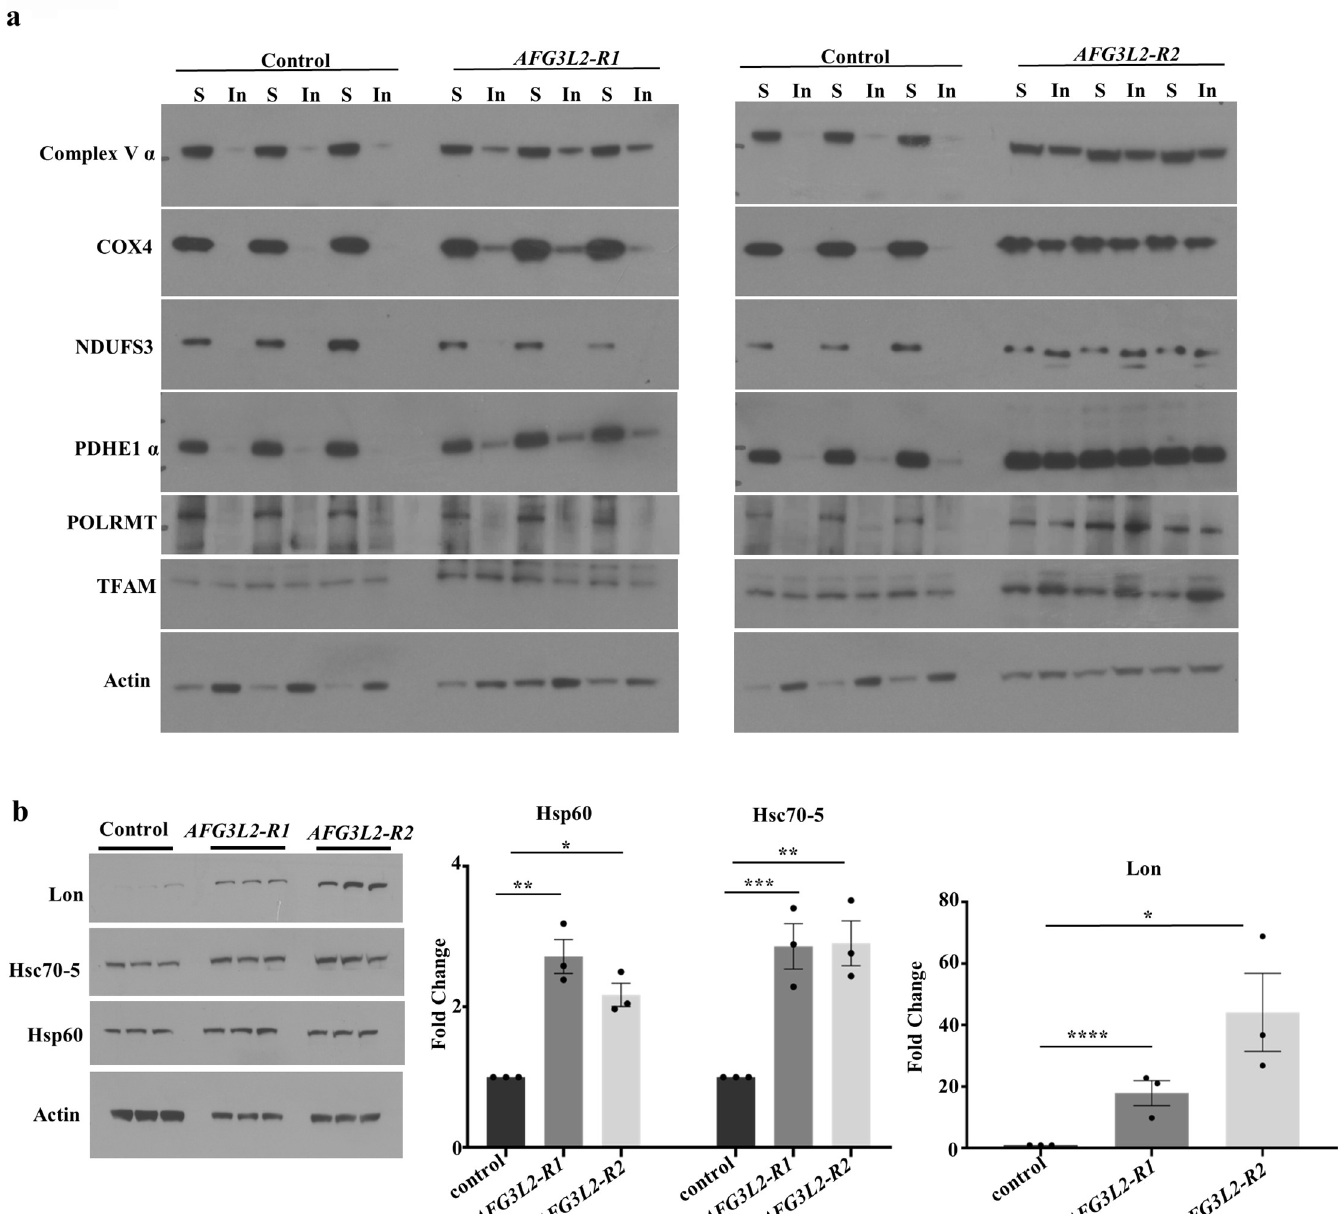
Fig 7. Afg3l2 deficiency results in the accumulation of insoluble mitochondrial proteins and activation of the mito-UPR. a. Results of western blot analysis of triton-soluble (S) and insoluble (In) mitochondrial protein fractions from control (UAS- LUCIFERASE RNAi/da-Gal4) and AFG3L2 -deficient ( AFG3L2-R1 ; UAS- AFG3L2-R1 RNAi; da-Gal4 and UAS- AFG3L2-R2 RNAi/da-Gal4) pupae using the indicated antisera. b . Results of western blot analysis of cell lysates from control (UAS- LUCIFERASE RNAi/da-Gal4) and AFG3L2 -deficient (UAS- AFG3L2-R1 RNAi; da-Gal4 and UAS- AFG3L2-R2 RNAi/da-Gal4) pupae using antisera to the mito- UPR markers Lon, Hsp60A and Hsc70-5. Quantification was performed after normalizing band intensity of each protein to actin (N = 3 independent groups of 5 pupae, � p < 0.05, �� p < 0.005, ��� p < 0.0005, ���� p < 0.0001 by one-way ANOVA Tukey’s test for multiple comparison).